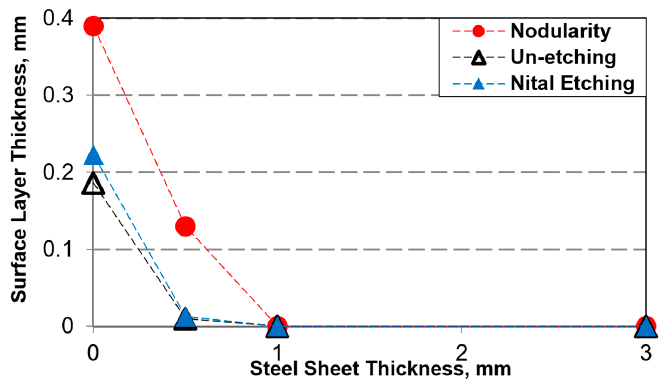
Figure 10. Influence of the steel sheet thickness on the degenerated graphite surface layer (skin) thickness.